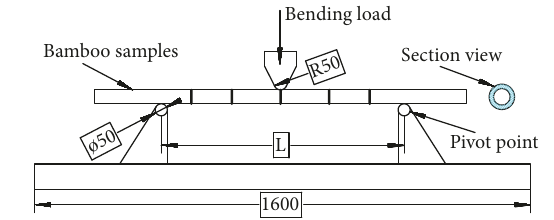
Figure 2: Schematic illustration of the three-point bending test setup. Note: all dimensions in